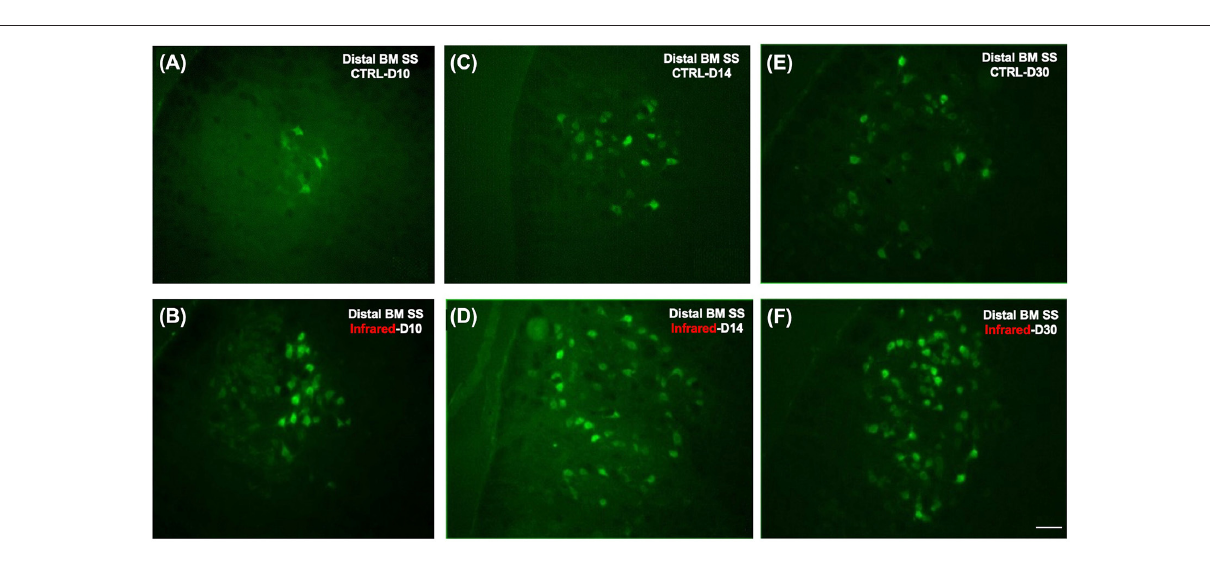
FIGURE 6 | Fluorescence photomicrographs of motoneurons retrogradely labeled with Fluorogold on the ipsilateral side after section-suture of the buccal and marginal mandibular branches. (A) : Distal BM SS - control group at D10 ( n = 12). Note that only a few cells are labeled. (B) : Distal BM SS - IR-treated group at D10 ( n = 12). Note that a few cells are labeled, as in the control group. (C) : Distal BM SS - control group at D14 ( n = 12). Note that the number of labeled cells is greater than at D10, although it remains low. (D) : Distal BM SS - IR-treated group at D14 ( n = 12). Note that the number of labeled motoneurons is greater than that in the control group. (E) : Distal BM SS - control group at D30 ( n = 12). Note that the number of labeled facial motoneurons has increased. (F) : Distal BM SS - IR-treated group at D30 ( n = 12). Note the larger number of FG-labeled motoneurons on the lesioned side of treated mice than on that of untreated mice (E,F) . Scale bars = 20 µ